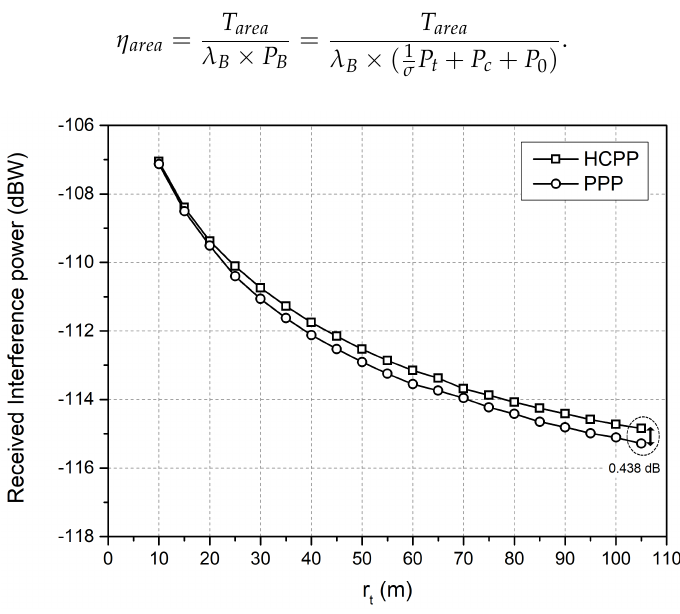
Figure 2. Received interference power by PPP and HCPP vs. thinning radius ( r t